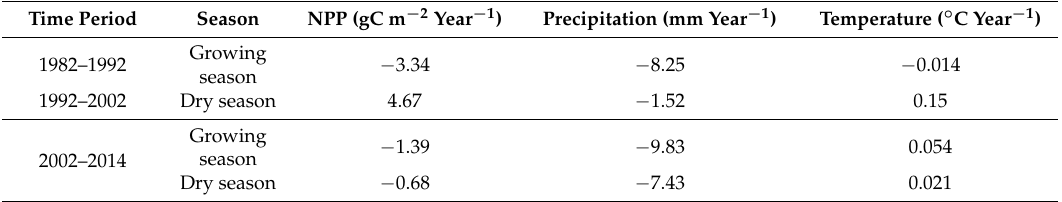
Table 4. Variation trends of NPP and climatic factors in the related seasons and stages.